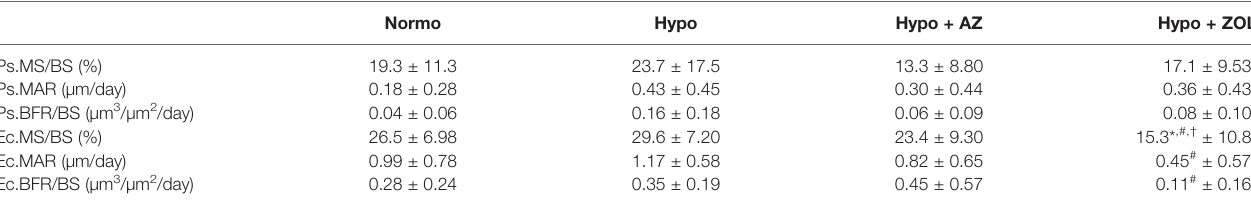
TABLE 5 | Mid-diaphyseal femoral cortical bone parameters determined by dynamic bone histomorphometry of mice housed at normobaric ambient pressure (Normo) or hypobaric pressure (Hypo) at 500 mbar for four weeks and treated with acetazolamide (AZ) or zoledronate (ZOL). Periosteal bone surface (Ps), endocortical bone surface (Ec), mineralizing surface/bone surface (MS/BS), mineral apposition rate (MAR), and bone formation rate